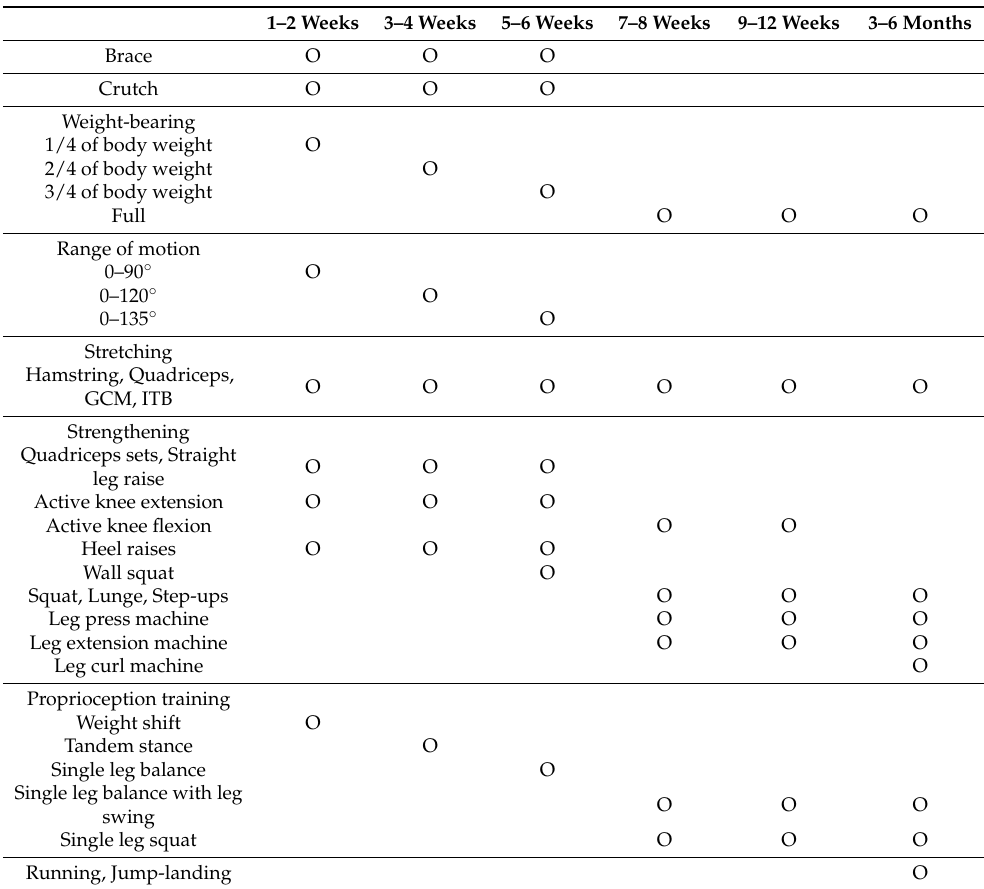
Table 1. Rehabilitation